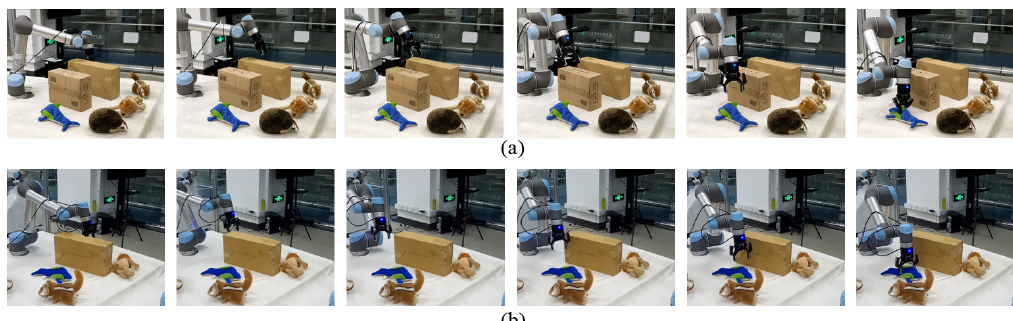
Figure 10. Frames of the final policies trained with our method employed on the manipulation task in real-world working scenarios. The robot gripper reaches the target object (toy dolphin) in 3D space and avoiding obstacles. ( a ) two obstacles. ( b ) one